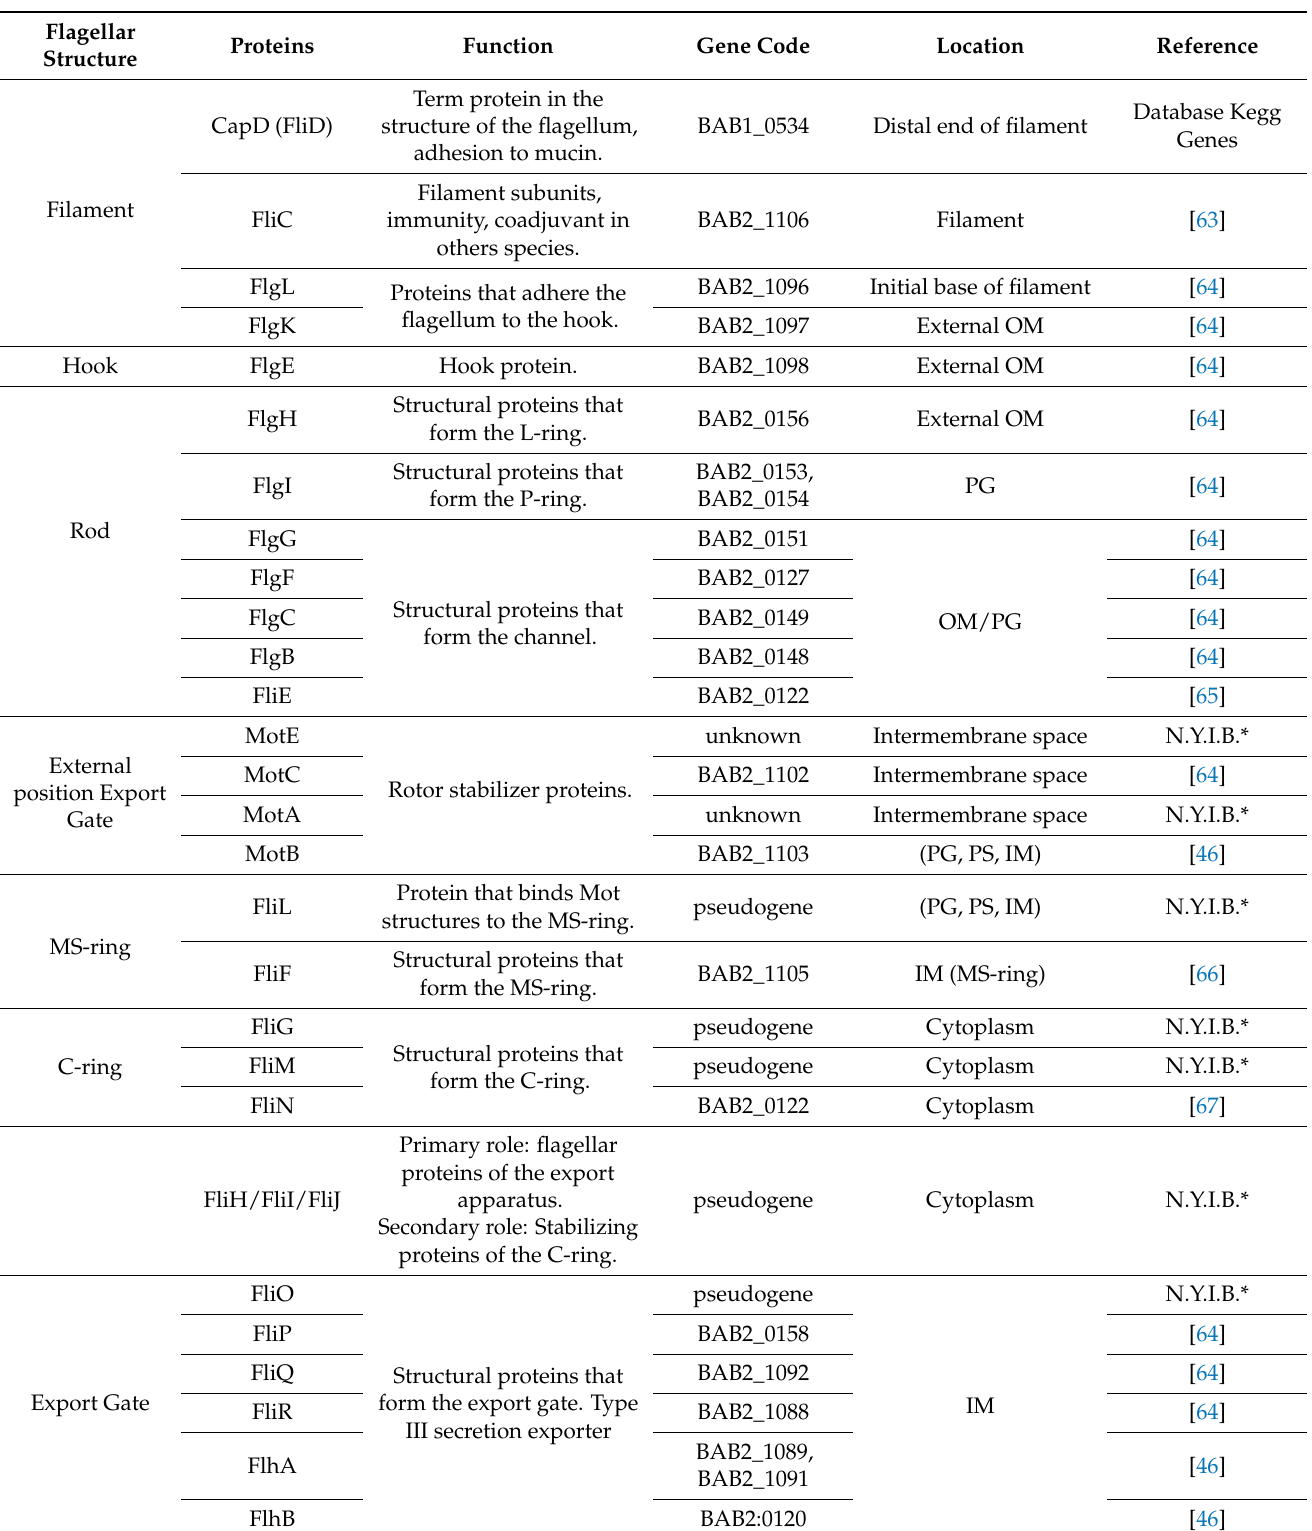
Table 1. The gene codes of Brucella abortus flagellar proteins are presented; in some cases, they are described as pseudogenes and have not been